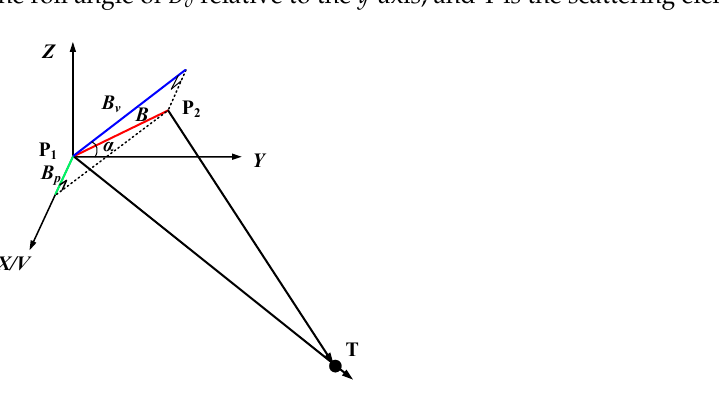
Figure 1. Schematic of the hybrid interferometry geometry.